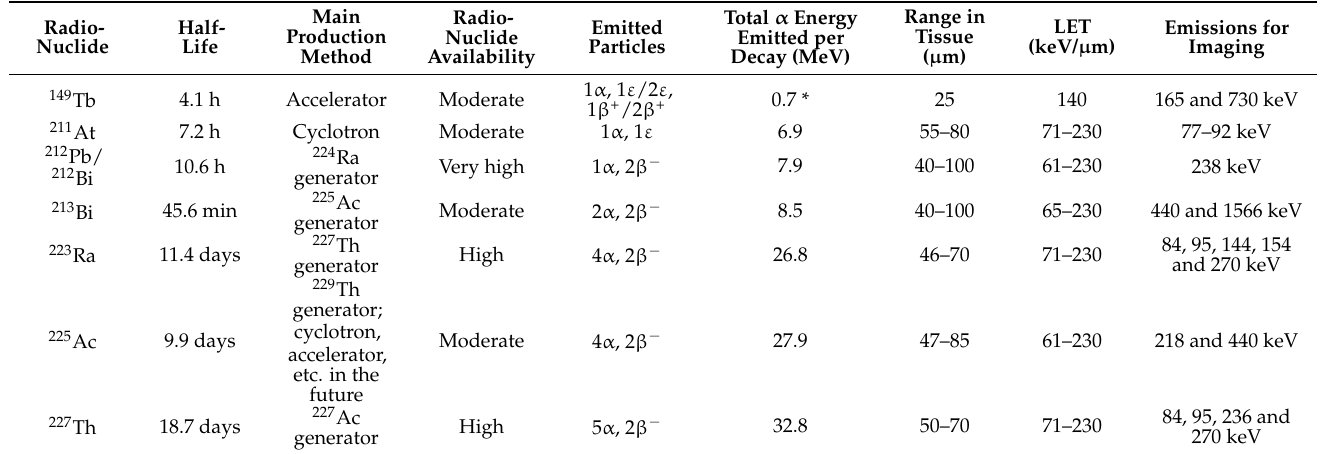
Table 2. Overview of α -emitting radionuclides used in PSMA-TAT [71–75].